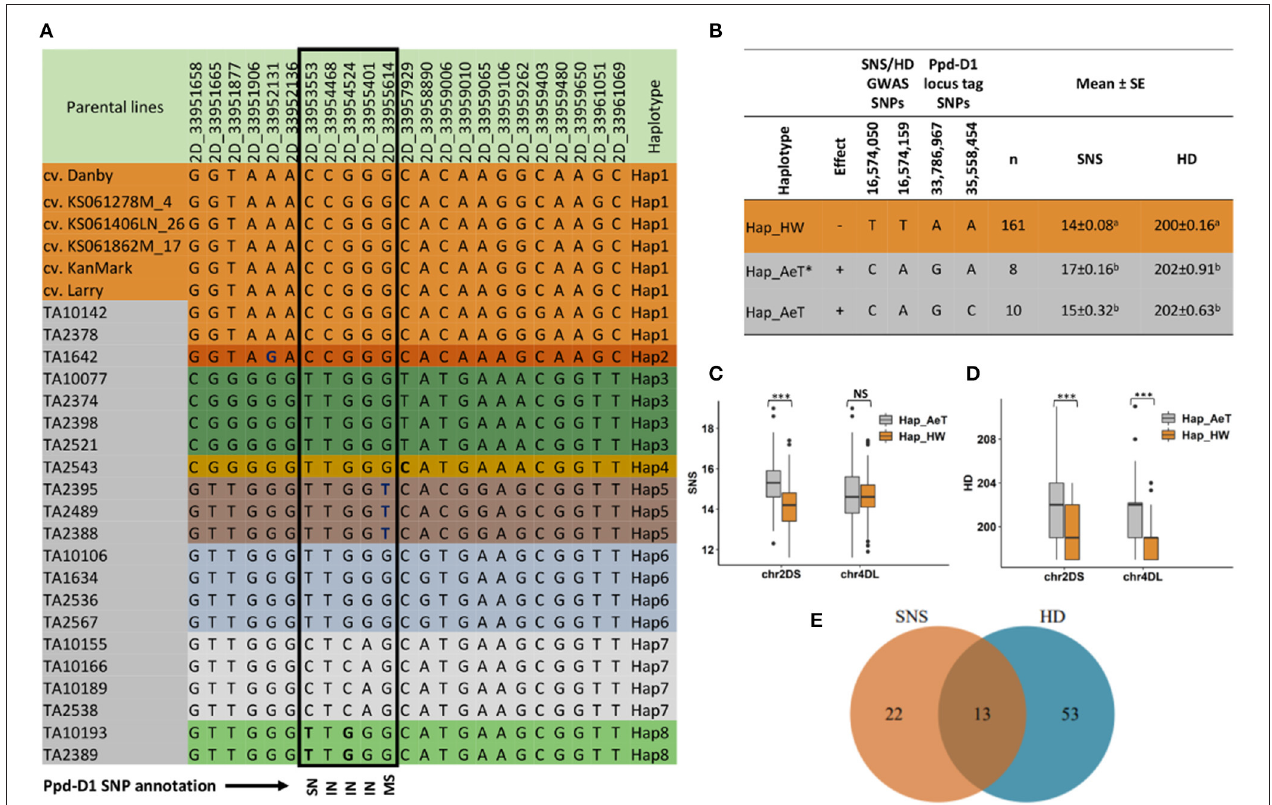
FIGURE 5 | Effect of haplotypes introgressed from Ae. tauschii into the chromosome arms 2DS and 4DL of hexaploid wheat on the spikelet number per spike (SNS) and heading date (HD) of the introgression lines and the possible link to Ppd-D1 gene located on 2DS. (A) SNP table showing the haplotype variants at the Ppd-D1 gene locus in winter wheat accessions (top six) and the 21 Ae. tauschii lines. The black rectangle shows SNPs within the coding region of the gene where SN is a synonymous SNP, IN is an intronic SNP and MS is a missense SNP (His16Asn) as reported by snpEff v4.3 software. (B) Unique haplotypes in the introgression population tagging the Ppd-D1 locus and GWAS signal for SNS and HD on chromosome arm 2D, and the associated phenotype. Hap_HW is present in introgression lines that have Hap1 from hexaploid wheat at the Ppd-D1 locus, Hap_AeT includes lines that have Hap3–6 and 8 while Hap_AeT* includes lines that have Hap2 and Hap7 at the Ppd-D1 locus in Ae. tauschii parents. The TT and CA alleles at the GWAS signal have reducing and increasing effects, respectively, on SNS and HD. Phenotype means with the same superscript letters are not significantly different at α = 0.05. (C) Boxplot showing the impact of introgression from Ae. tauschii in chromosome arms 2DS and 4DL on SNS. (D) Boxplot showing the impact of introgression from Ae. tauschii in chromosome arms 2DS and 4DL on HD. (E) A Venn diagram showing the number of introgression lines in the 90th percentile for SNS and HD. Lines in the intersection have the increasing alleles on both 2DS and 4DL loci associated with SNS and HD. *** indicates significant difference between groups with p < 0.001 while NS indicates a nonsignificant difference based on t -test